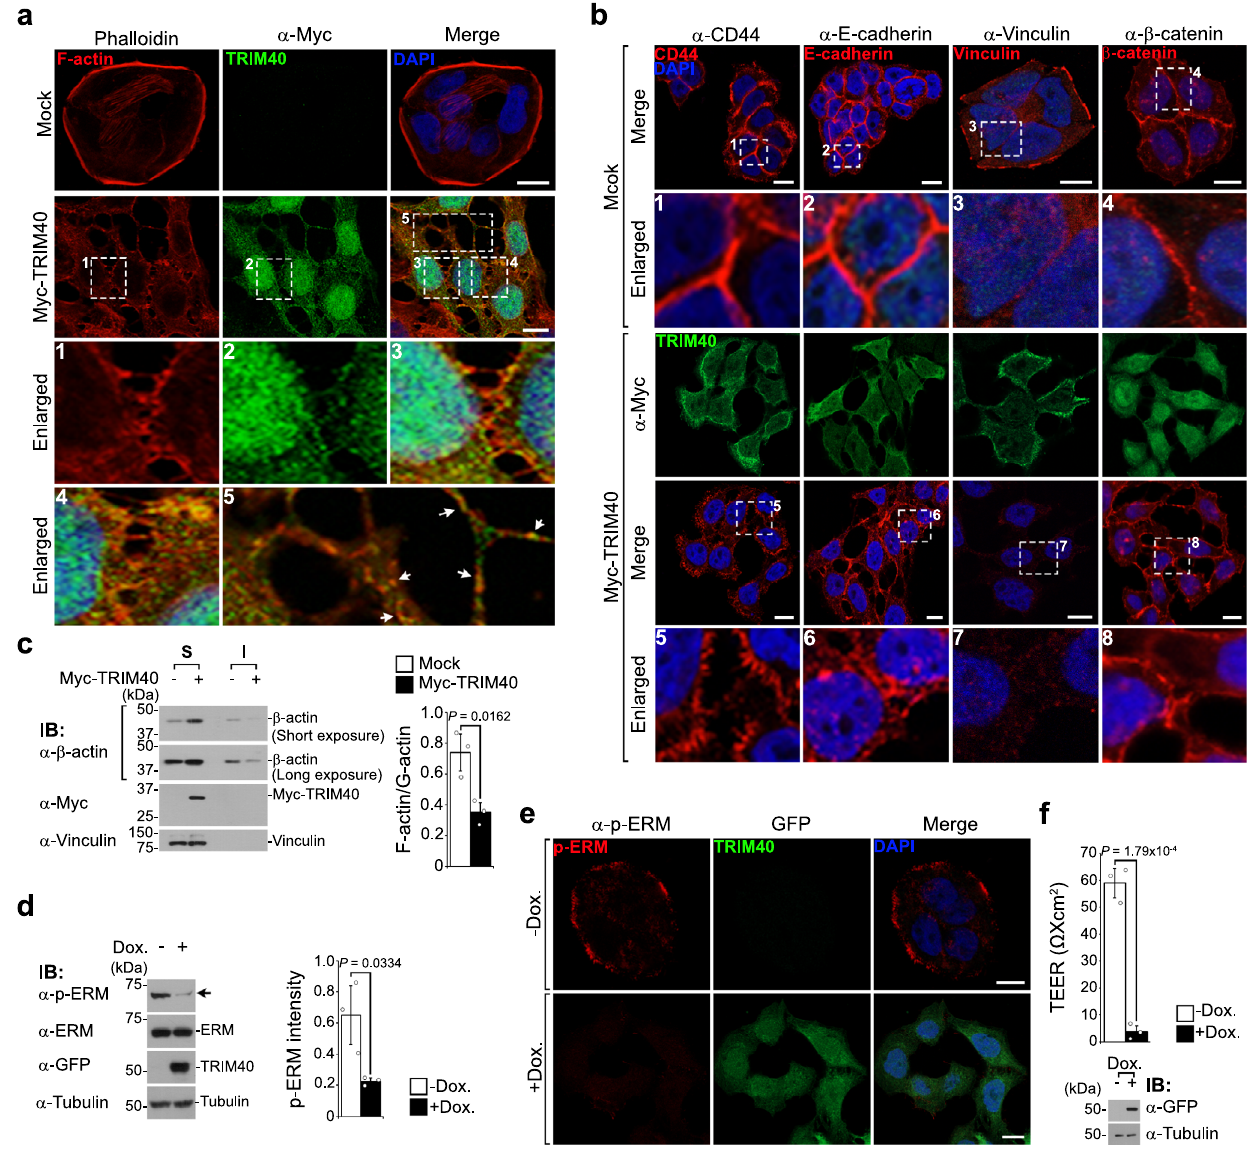
Fig. 2 | TRIM40 disrupts epithelial integrity by destabilizing cortical actin cytoskeleton. a , b Confocal fl uorescent images of HT-29 cells expressing control vector or Myc-TRIM40. Cells were stained with anti-Myc antibody (Myc-TRIM40, green) and phalloidin (F-actin, red) ( a ). For confocal microscopy analysis of pro- teins located in cell-to-cell junctions, cells were stained with anti-Myc antibody (Myc-TRIM40, green) and anti-CD44, anti-E-cadherin, anti-Vinculin, or anti- β - cateninantibodies(AJproteins,red)( b ).Enlargedviewsoftheregionsaredenoted by the white dashed squares. White arrows in image #5 represent the partial colocalization of TRIM40 with irregular accumulation of F-actin on fi lamentous stretches. Nuclei were stained with 4 ′ ,6-diamidino-2-phenylindole (DAPI, blue). Scale bars, 10 µ m. ( n ≥ 3biological independent experiments). c Immunoblots showing β -actin levels in soluble (S) and insoluble (I) fractions from HT-29 cells expressing control vector or Myc-TRIM40. Graphs showing the ratios of F-actin to